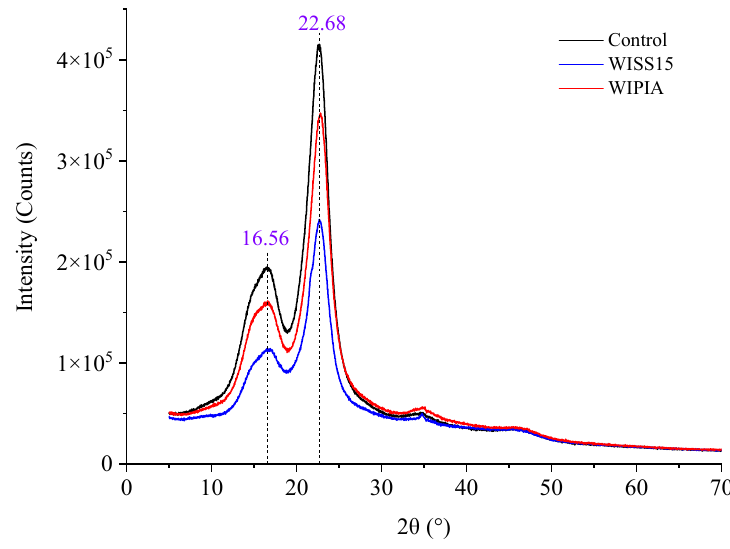
Figure 3. XRD spectra of the wood samples.